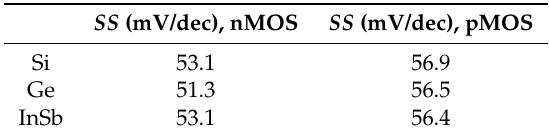
Table 1. Summary of analytically calculated SS values in π -FETs for various bulk semiconductor materials. nMOS and pMOS stands for an n-type and p-type MOSFET,